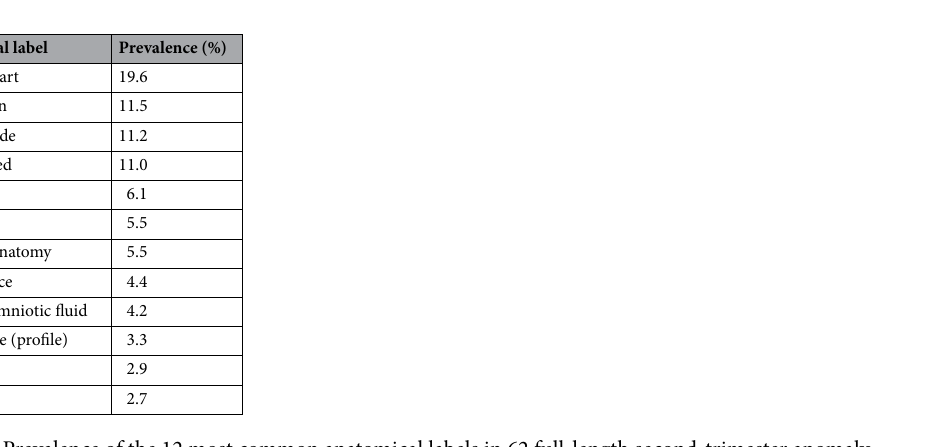
Table 1. Prevalence of the 12 most common anatomical labels in 62 full-length second-trimester anomaly scans.